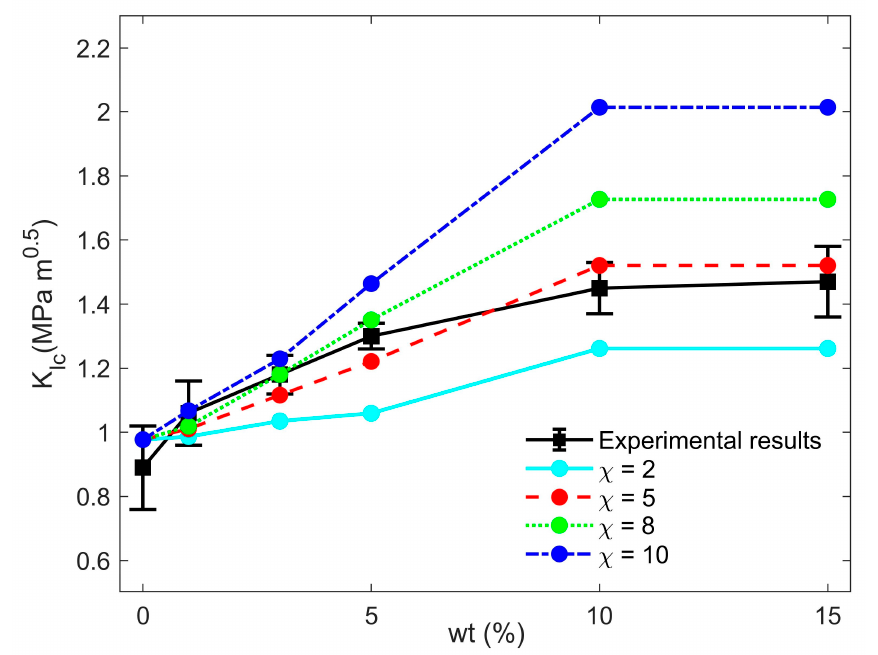
Figure 11. Results of the numerical model calibration.